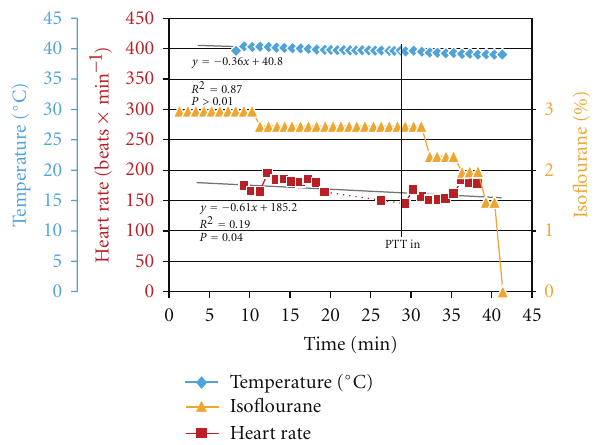
Figure 3: Example of eider cloacae temperature ( ◦ C) compared to heart rate (beats × min − 1 ) and Isoflurane concentration (%) versus time (min) during intracoelomic PTT implantation (ID no. 8). In this case, the PTT was preheated to 35 ( ◦ C). Broken lines: data gaps. Results from the linear regressions are